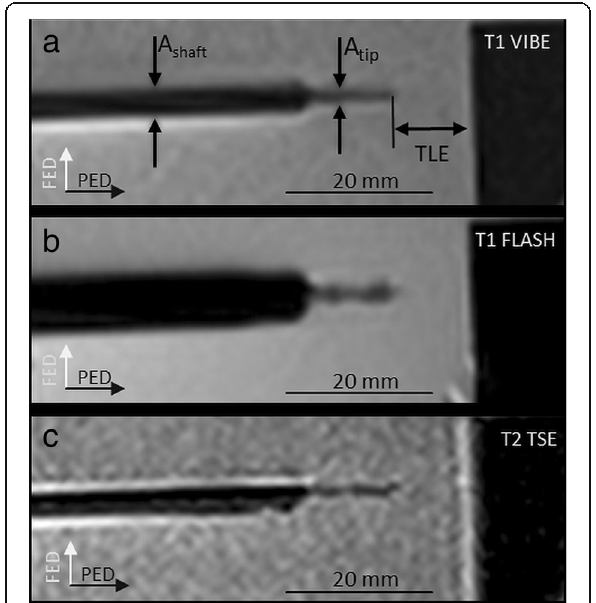
Fig. 4 Artefact of the MW applicator according to the angulation to B 0 . Images are acquired with T1W-VIBE sequence (see text for sequence details) with an applicator angulation to B 0 of 0°( a ), 45°( b ), and 90°( c ). The diameter of shaft artefact was significantly dependent on the angulation with the smallest diameter with an angulation parallel to B 0 . PED Phase encoding direction, FED Frequency encoding direction